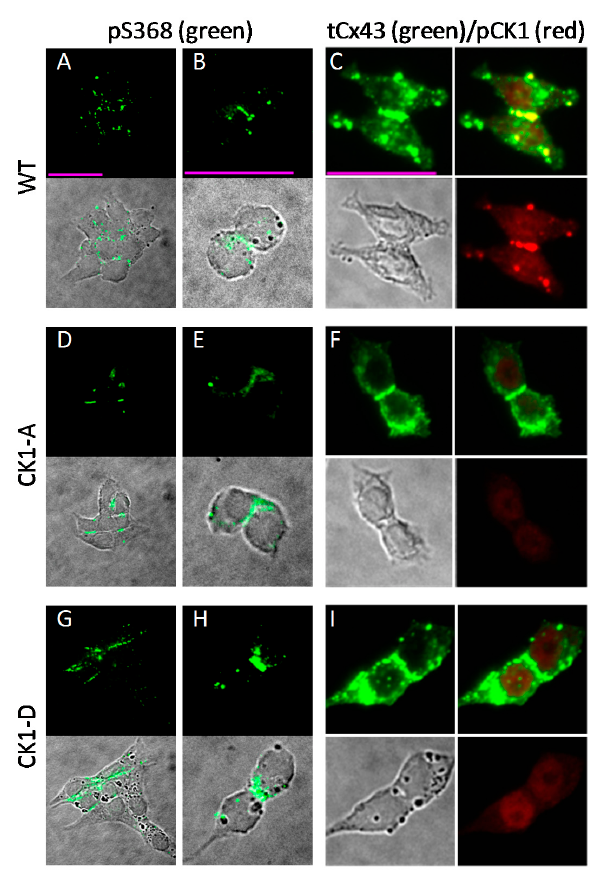
Figure 6. Residue S368 of Cx43 is phosphorylated in Rin cells expressing Cx43-WT, Cx43-CK1-A or Cx43-CK1-D. ( A , B , D , E , G , H ) Fluorescent (upper) and fluorescent merged with the corresponding differential interference contrast (DIC, lower) images of cells stained with a Cx43-pS368 phospho-specific antibody (pS368). Cx43-pS368 (green) was found in junctional plaques in groups and isolated pairs of Cx43WT ( A , B ), Cx43-CK1-A ( D , E ) and Cx43-CK1-D ( G , H ) cells. ( C , F , I ) DIC and fluorescent images of cells stained simultaneously with a polyclonal Cx43 antibody (“total” Cx43, tCx43) and a phospho-specific antibody against Cx43-p CK1 (pCK1). In all groups, total Cx43 (green) was found in junctional plaques and other cell areas ( C , F , I , upper left panels). Bona fide CK1-phosphorylated Cx43 (red) was found only in Cx43WT cells ( C , bottom right) colocalized with a membrane fraction of total Cx43 at junctional plaques ( C , upper right, yellow). The pCK1 antibody labels a non-specific nuclear signal in the dephospho- ( F ) and phospho-mimicking ( I ) mutant expressing cells that is also found in parental Rin cells, devoid of connexins (Figure S5). Calibration bars (pink lines, 25 μ m) apply to each column.